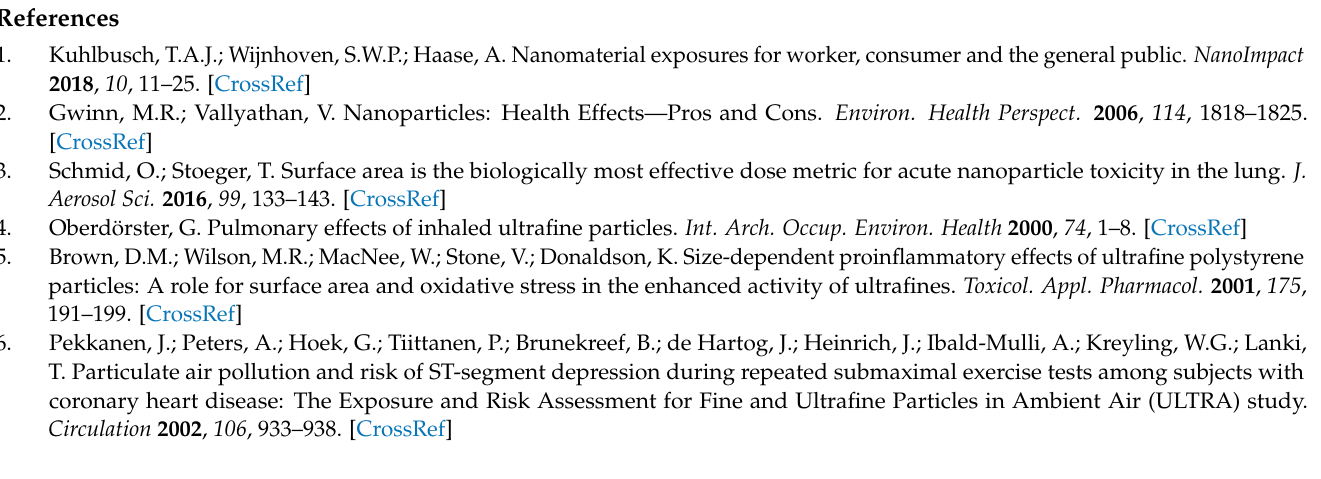
Table S3. Heating program for acid digestion of the filter samples, Table S4. Results from ICP-OES, Figure S1. Experimental setup: inside the spray chamber (above), NF (middle) and FF (bottom), Figure S2. Record of aerosol particle number concentrations coming from an external source, Figure S3. Averaged particle number concentration versus tests. NF